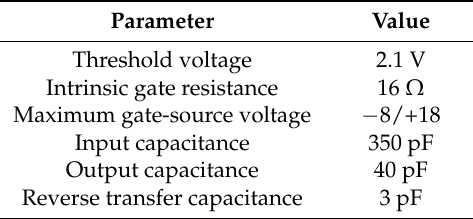
Table 2. Parameters of the C3M0120090J.